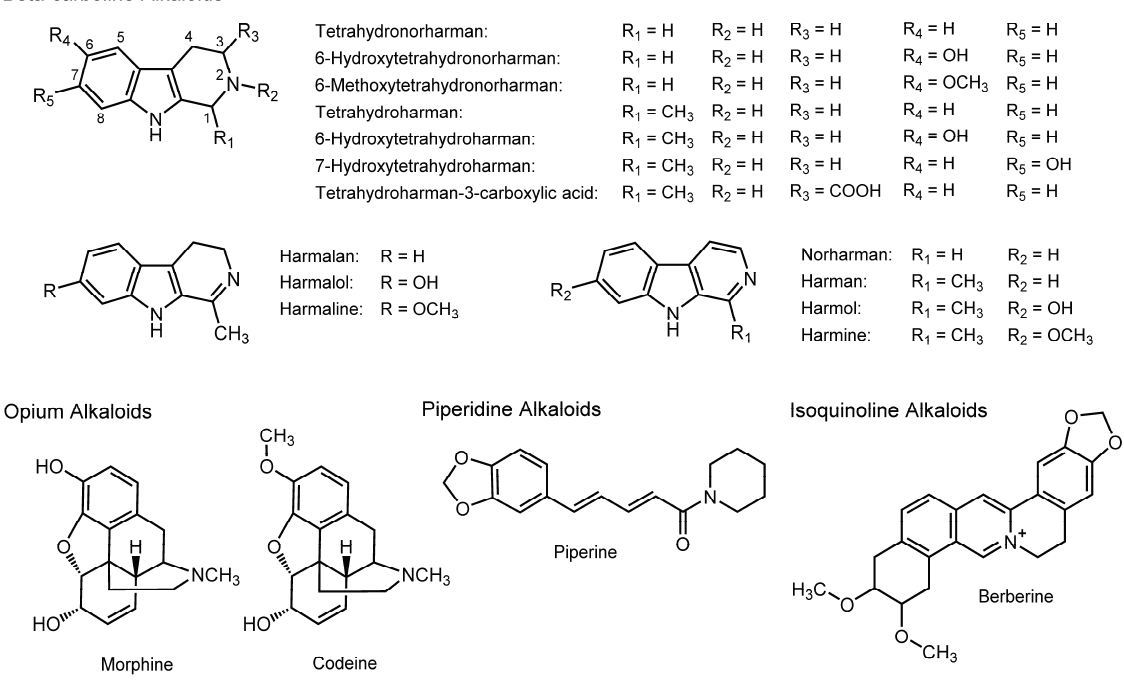
Figure 7. Structures of membrane-interactive